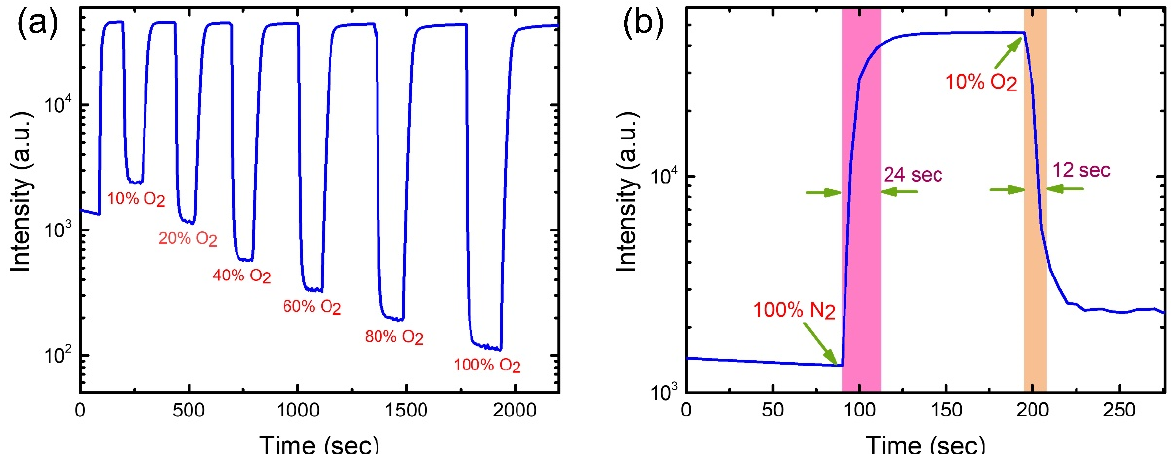
Figure 10. ( a ) Dynamic response of PtTFPP oxygen sensor on AAO membrane with gradual change in O 2 concentrations. ( b ) A zoomed-in plot of ( a ) to estimate the response and recovery time.